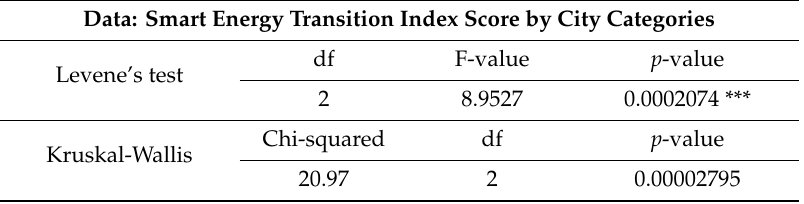
Table 9. Levene’s test for homogeneity of variance and Kruskal-Wallis test.